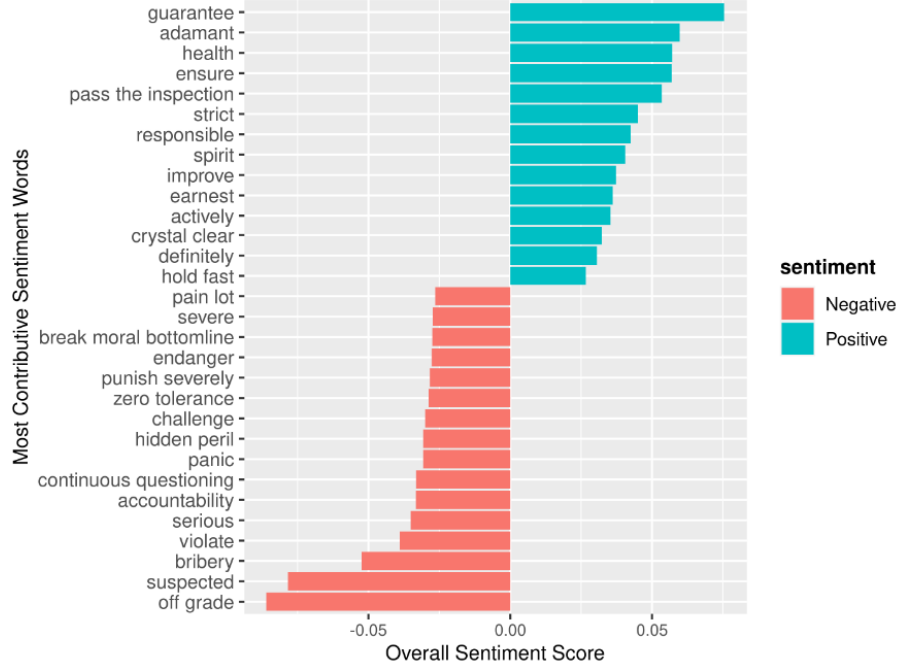
Figure 6. Sentiment scores of the 17 topics.